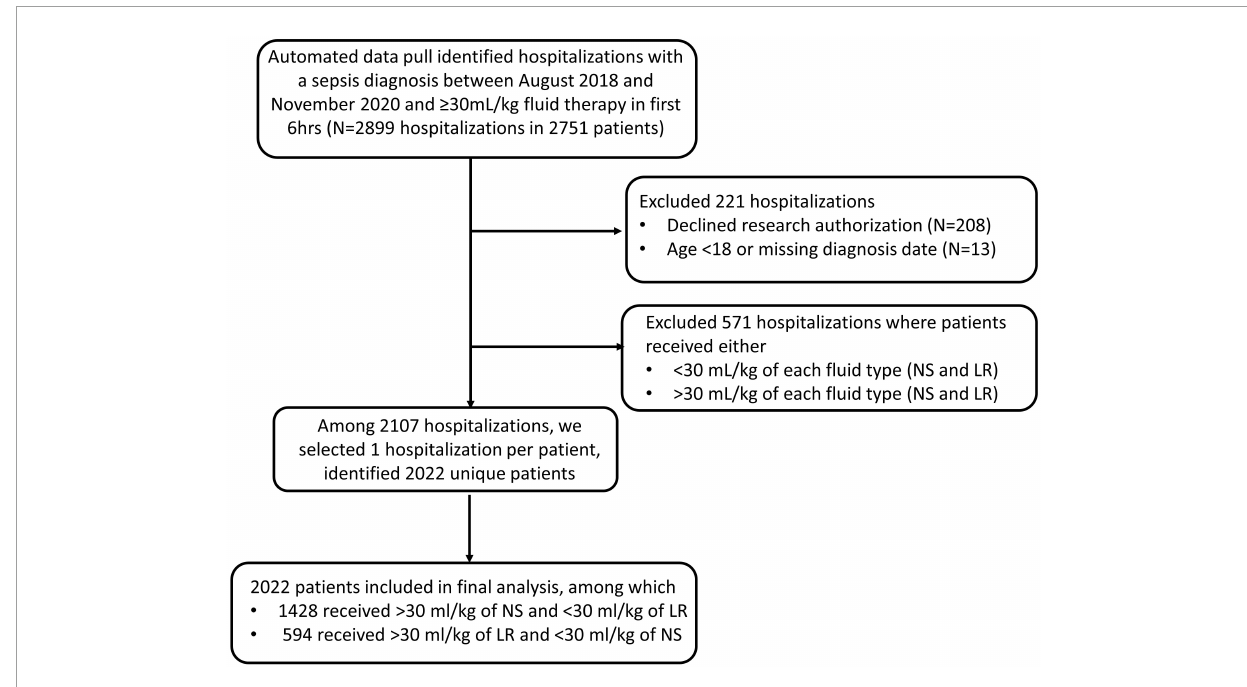
FIGURE1 Flowchart showing inclusion and exclusion of patients in the study cohort.